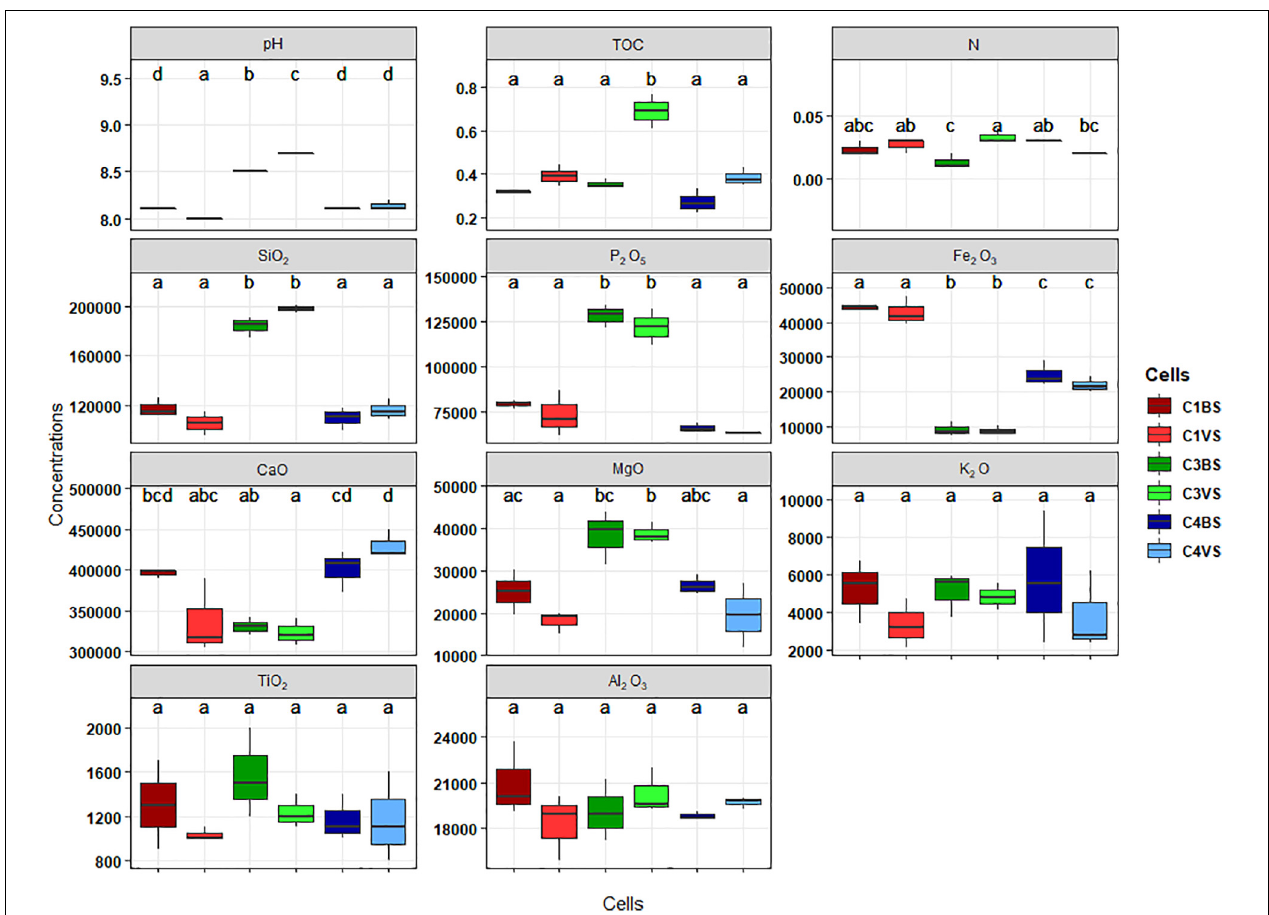
FIGURE 1 | Boxplot displaying the concentrations of different chemical parameters. Organic carbon (OC) and nitrogen (N) are presented by percent. Major oxides such as silica (SiO 2 ), phosphorus pentoxide (P 2 O 5 ), ferric oxide (Fe 2 O 3 ), lime (CaO), magnesia (MgO), potash (K 2 O), titanium oxide (TiO 2 ), and alumina (Al 2 O 3 ) are in milligrams per kilogram. The letters present the compact display letters (CDL). Error bars represent standard deviation of the mean value (analyses performed in triplicates). Values in each column followed by the same letter are not significantly different at 0.05%